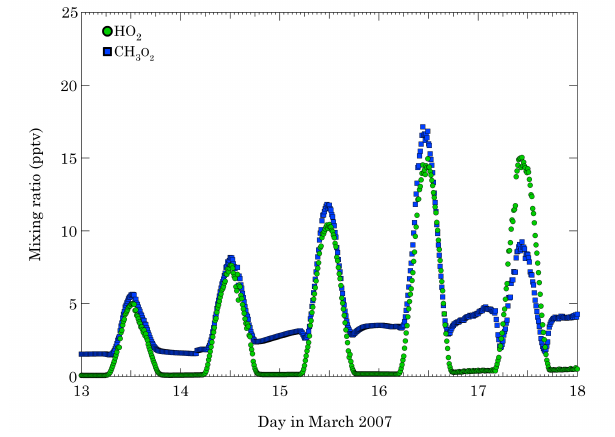
Fig. 13. PERCA measured RO x vs. PSS calculated RO x . The red dashed line illustrates the 1:1